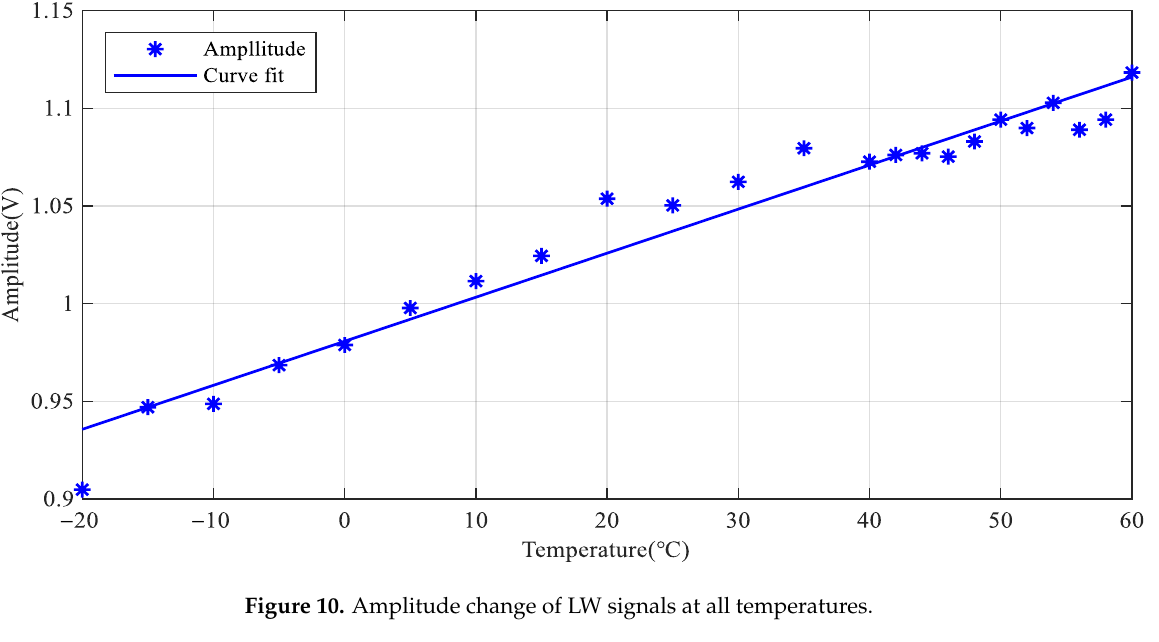
Figure 9. LW signals of central frequency 200 kHz at all temperatures.